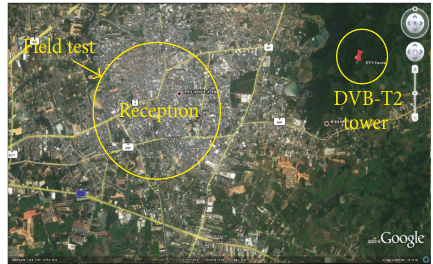
Figure 3: Measurement locations in Songkla Province.